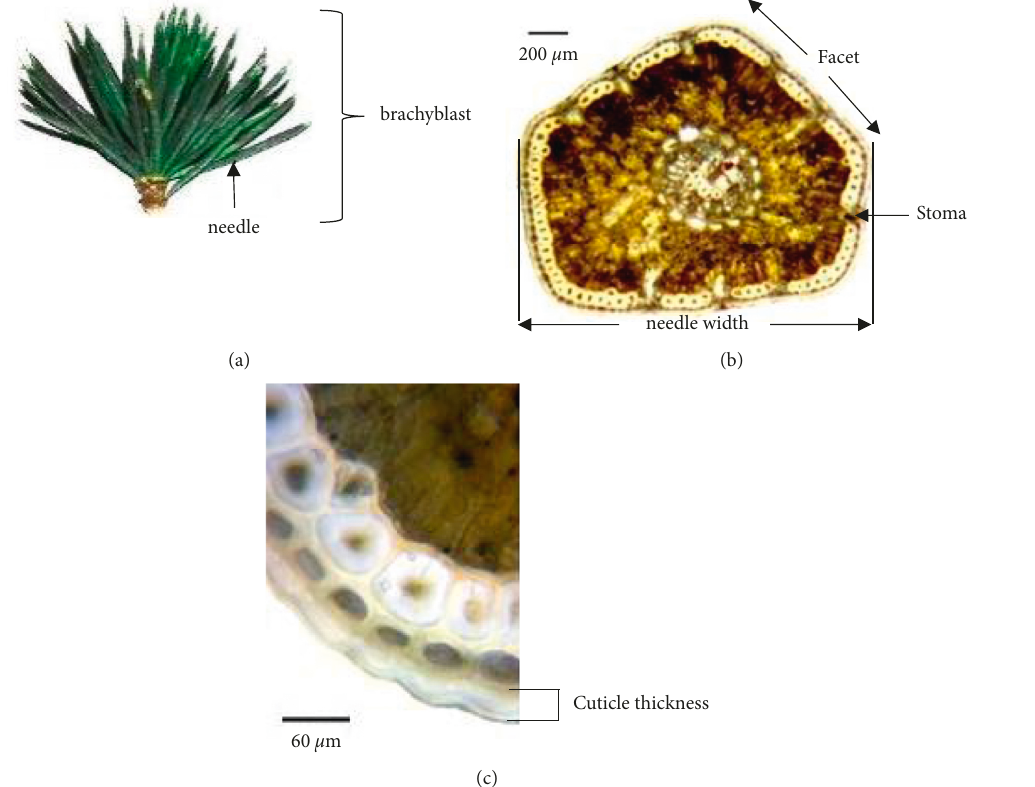
Figure 1: Measured characters of C. atlantica needle. (a) The image indicating needles of brachyblast, (b) The image indicating stoma, facet, and needle width. (c) The image indicating cuticle thickness.